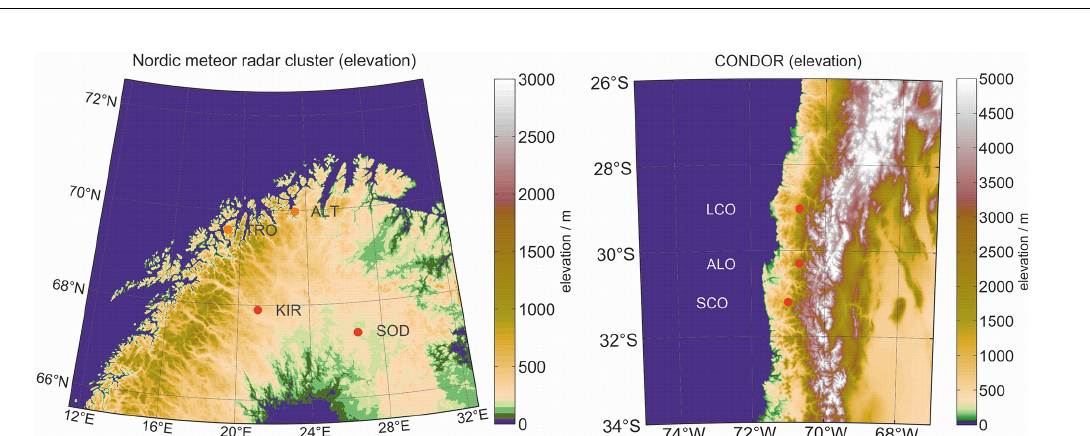
Figure 1. Nordic Meteor Radar Cluster and CONDOR locations visualized with color-coded mean elevation. The maps were generated from etopo1 using the m_map package (Amante and Eakins,